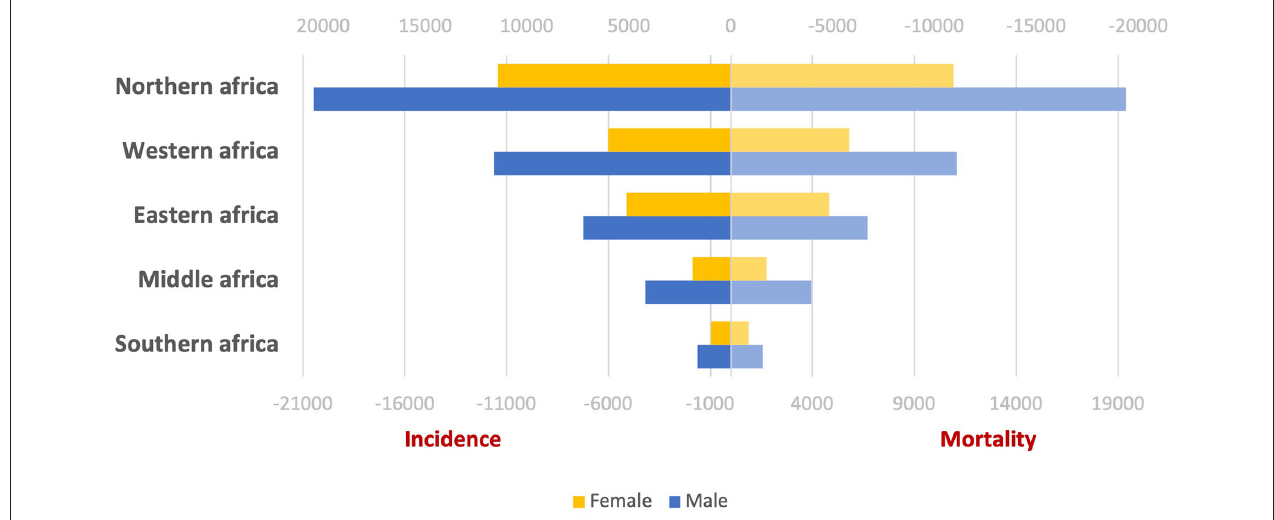
FIGURE 1 | Incidence and mortality of liver cancer in different regions of Africa.